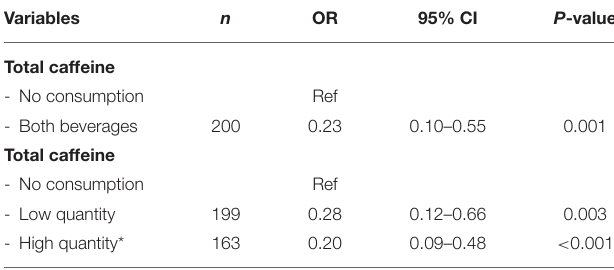
TABLE 4 | Evaluation of total caffeine as no consumption and consumption of both beverages and total caffeine as both beverages in low vs. high consumption—multivariate analysis adjusted for smoking history and